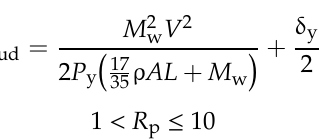
Figure 13. Simplified load ( P )–deflection ( δ ) relation of the RC beam; ( a ) Calculated P – δ relation (reprint of Figure 3), ( b ) Simplified P – δ relation.